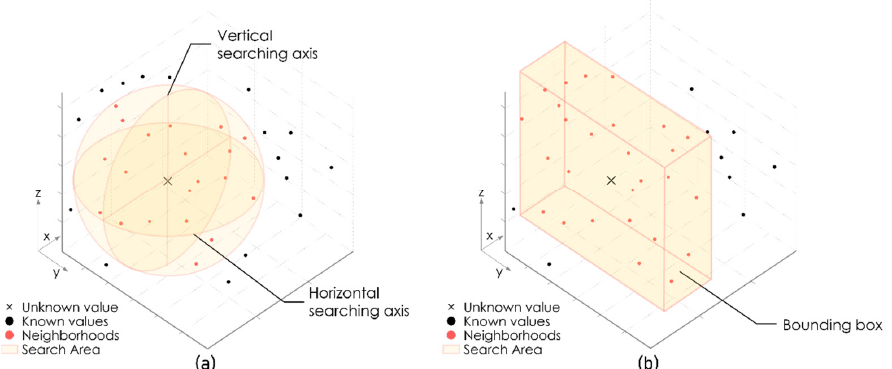
Figure 4. Proposed approaches for 3D search neighborhoods: ( a ) Spheroid ‐ based approach; ( b ) bounding box ‐ based approach.